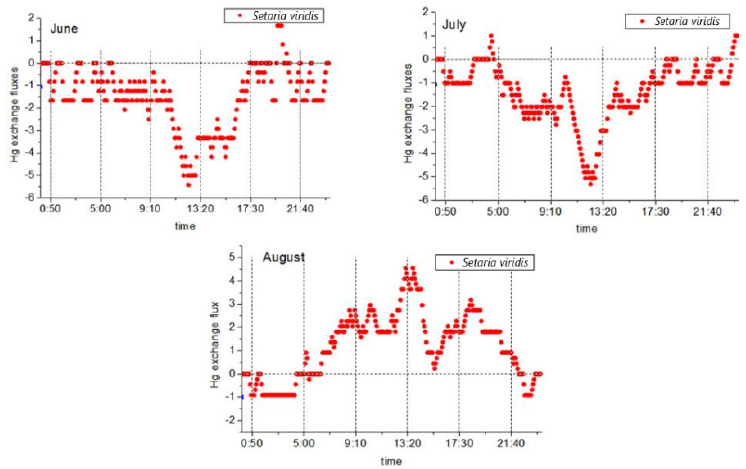
Figure 4. Changes in the daily mercury fluxes of S. viridis during different months.